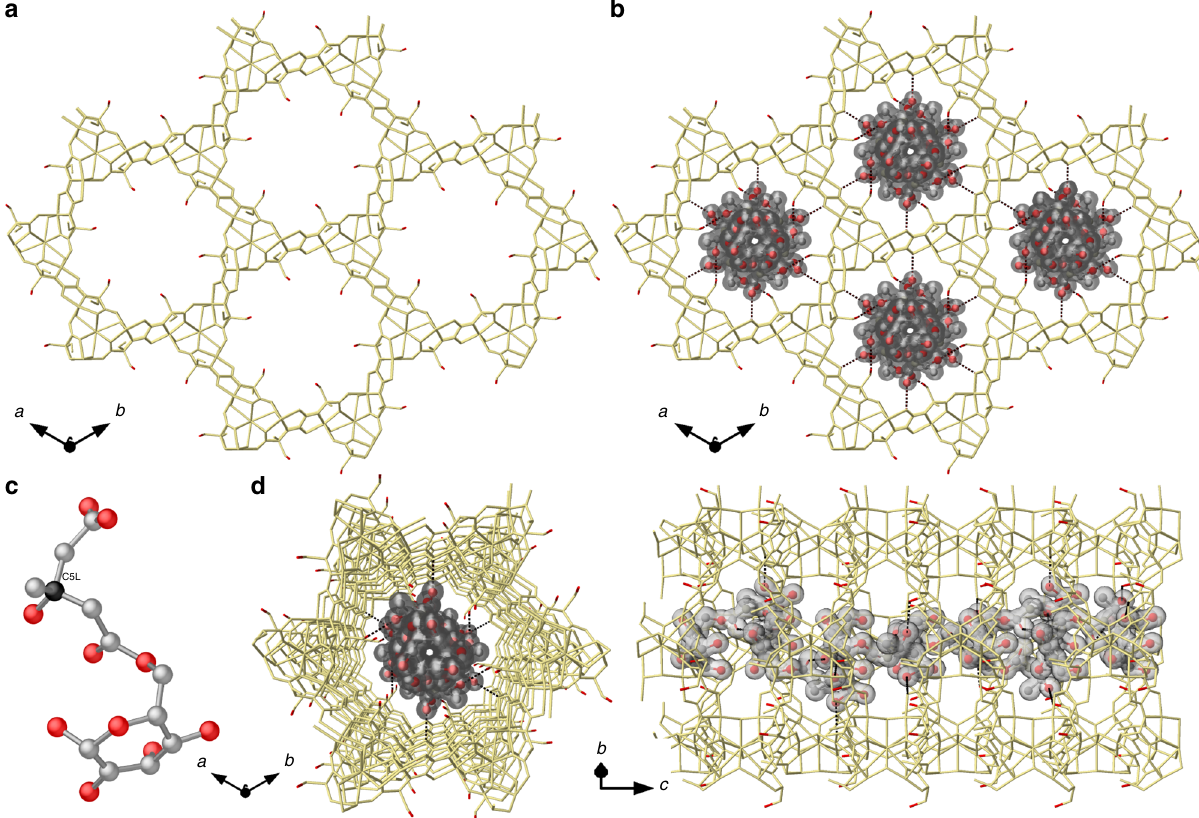
Fig. 4 Crystal structure resolution of brutieridin 11. Views of the 3D open-framework of MOF 2 ( a ) and 11a@2 ( b ) along the c -axis (the crystallization water molecules are omitted for clarity). The 3D networks are depicted as gold sticks, with the only exception of serine residues oxygen atoms, which are represented as red sticks. c View of fragment of 11a encapsulated within channels. d Top (left) and side (right) perspective views of a single channel of 11a@2 . Dashed lines represent hydrogen bonds between guest molecules involving also hydroxyl groups from the amino acid residue. The molecules of 11a are shown as red (oxygen) and gray (carbon) stick/solid